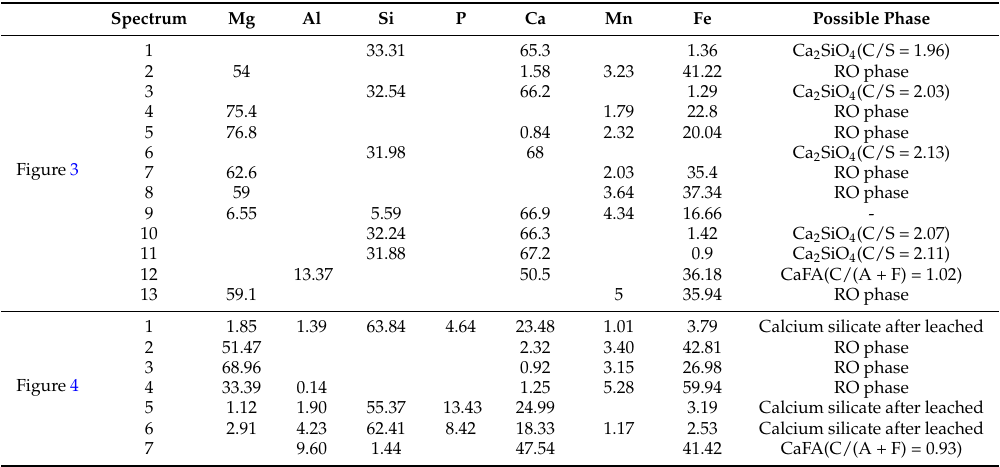
Table 1. The related results of energy dispersive spectrometer (EDS) (Atomic percent)/%.